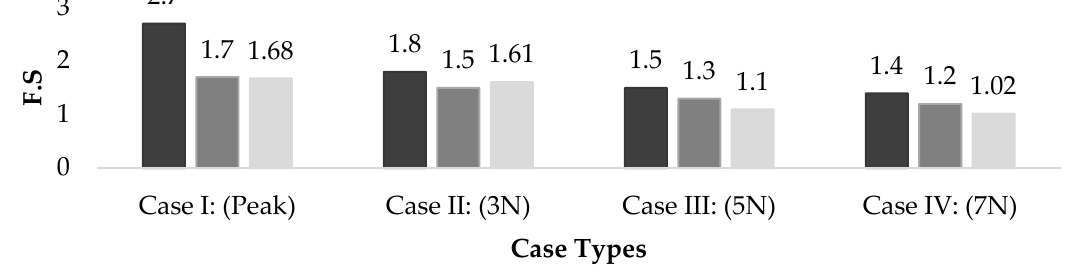
Figure 12. Change in the factor of safety.